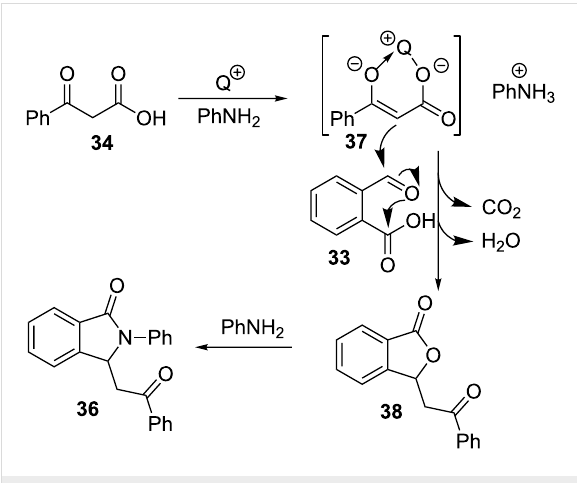
Scheme 10: Proposed mechanism for the formation of isoindolinones 36